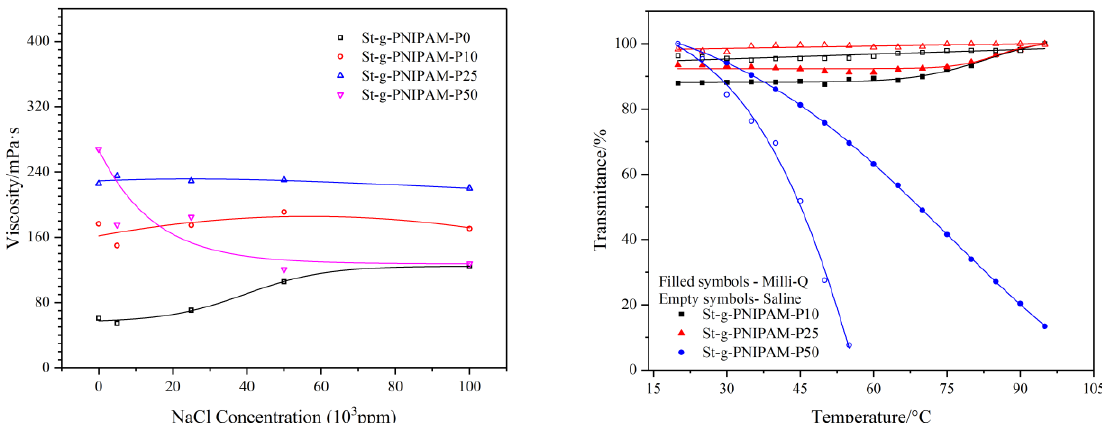
Figure 5. Viscosity versus temperature of ( A ) St-g-PNIPAM-P0; ( B ) St-g-PNIPAM-P10; ( C ) St-g-PNIPAM-P25; and ( D ) St-g-PNIPAM-P50 with 1.2 wt % copolymer concentration.